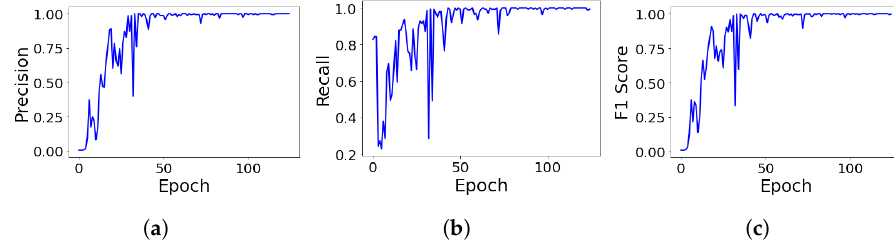
Figure 6. ( a ) Precision, ( b ) recall, ( c ) F1 score evaluated on the YOLOv5 validation set.